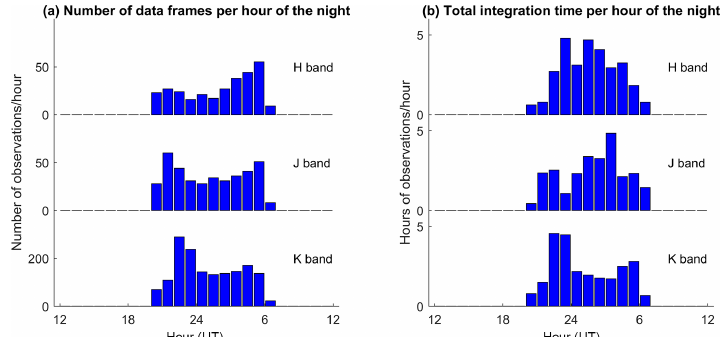
Figure 7. (a) Total number of spectroscopic data frames recorded in each hour and each band with NOTCam between November 2007 and June 2016. (b) Total hours of on-target integration time for spectroscopic data recorded in each hour and each band with the NOTCam in the same period of